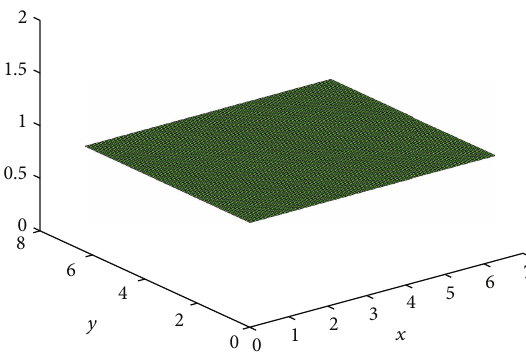
Figure 10: Initial condition with 𝑘 1 = 𝑘 2 = 𝛼 = 1 , at 𝑡 = 0 .